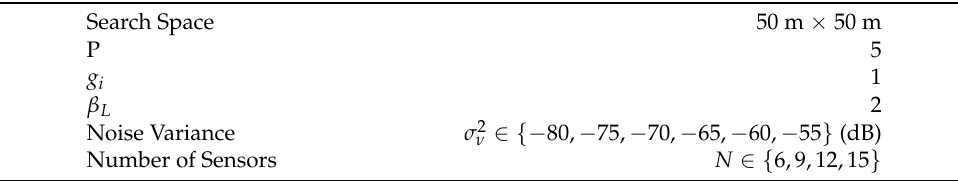
Table 5. Test parameters.